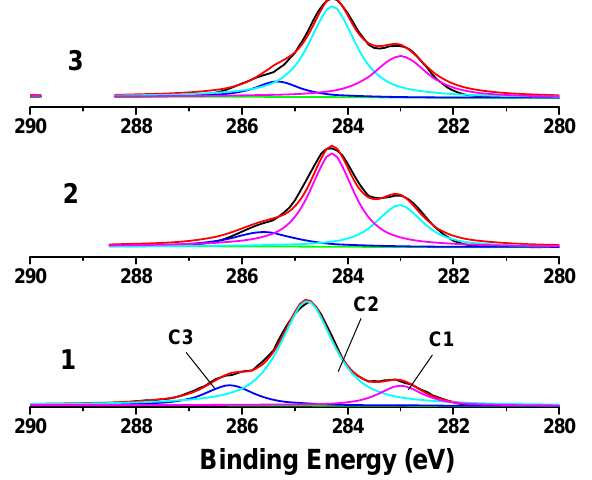
Figure 7. C XPS patterns of MCC with different crystalline degree show the three phases 1s of C : Sample 1 (Xc = 92.23%); Sample 2 (Xc = 71.73%); Sample 3 (Xc = 1S